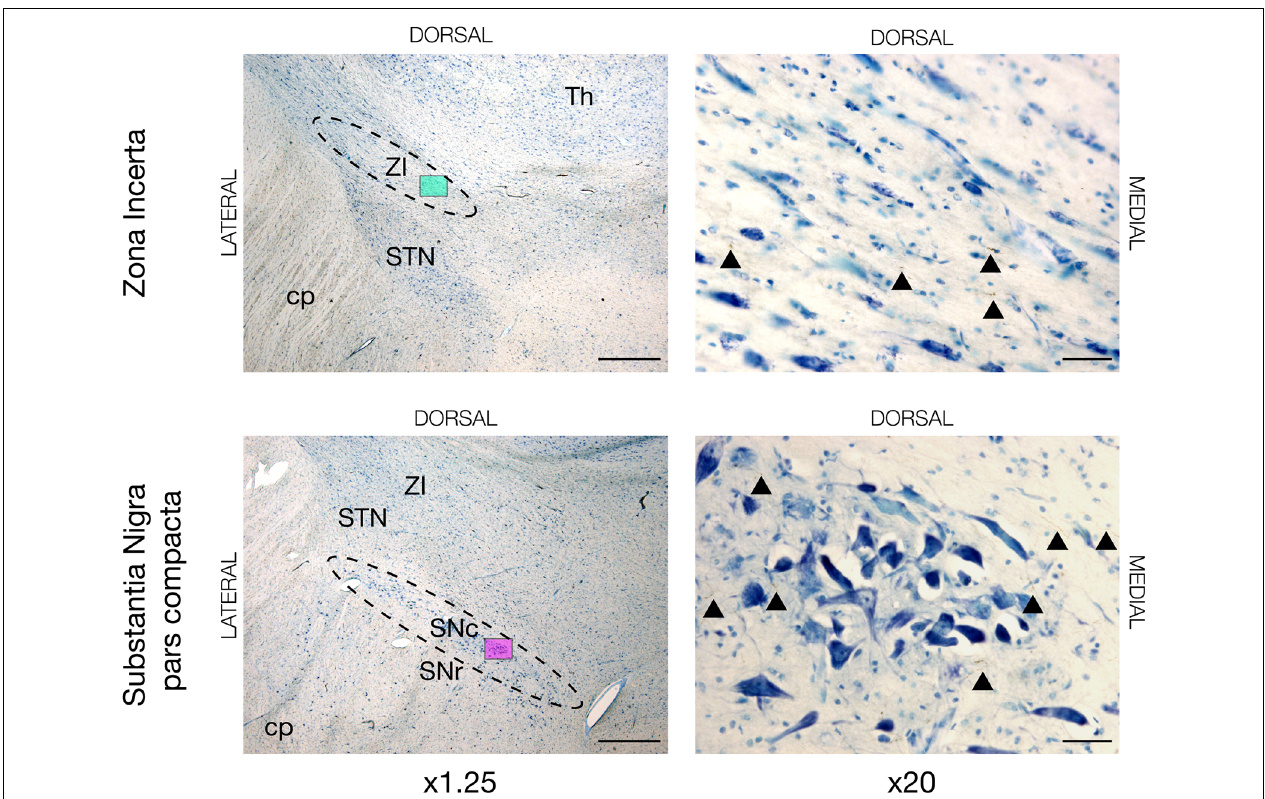
FIGURE 4 | Neuronal tracing with BDA in the zona incerta (ZI) and substantia nigra pars compacta (SNc) of JBG-3. The left overview column is shown in x1.25 magnification marked with a colored miniature window, which is then shown in x20 magnification in the right column. BDA labeled axons are golden-brown and marked with arrowheads. STN, subthalamic nucleus; cp, cerebral peduncle; Th, thalamus; SNr, substantia nigra pars reticulata. Counterstaining with toluidine blue. Scale bars = 1mm (x1.25) and 50 µ m